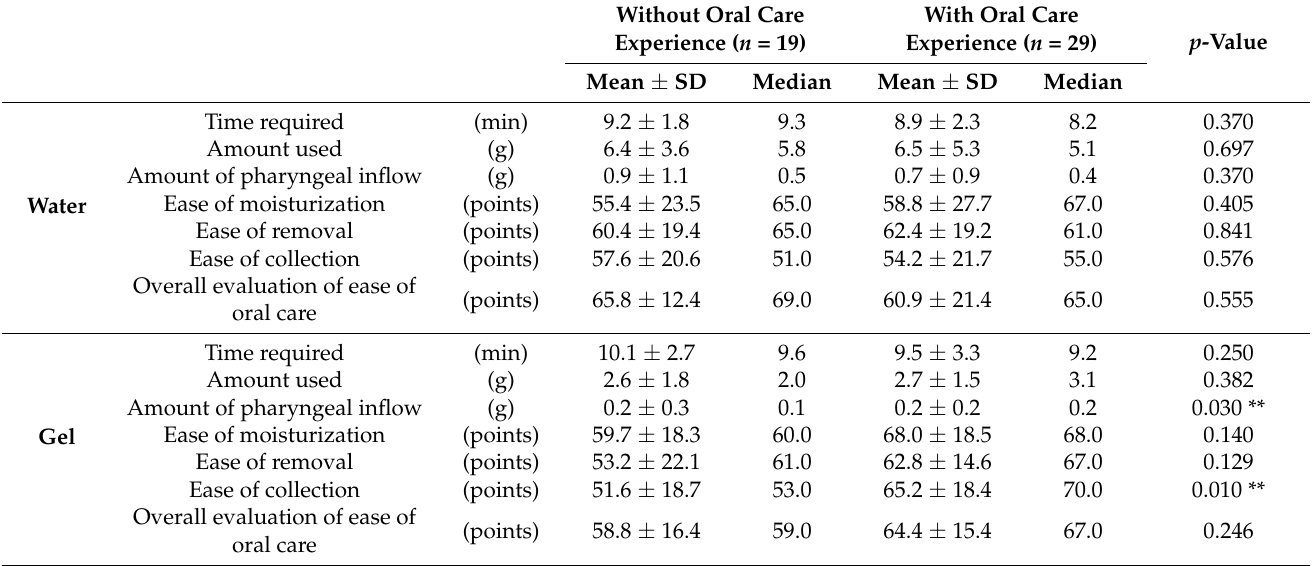
Table 5. Comparison of oral care with or without oral care experience for older adults in dental